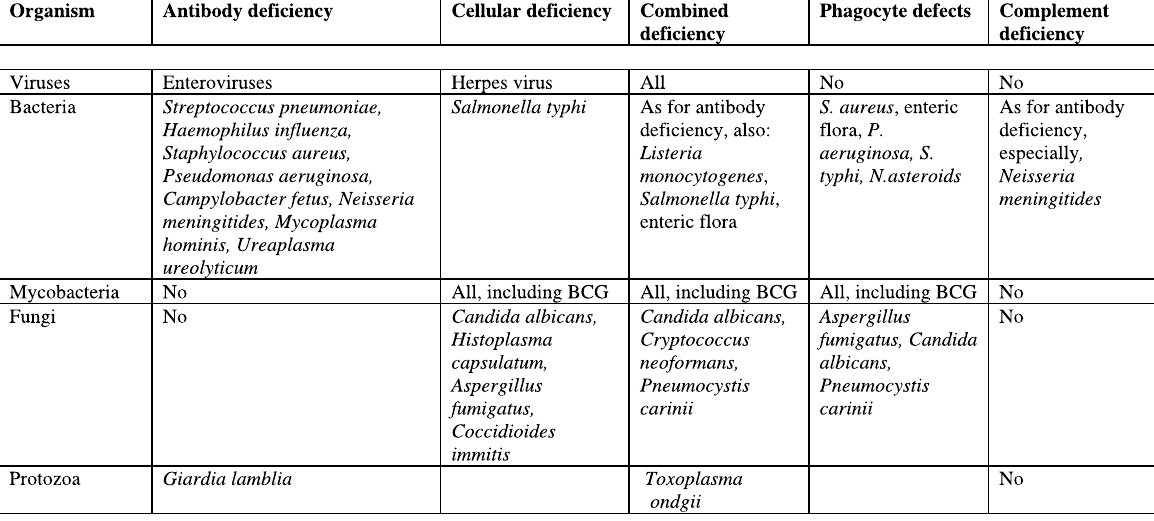
Figure 1. Infectious organisms associated with major categories of immune